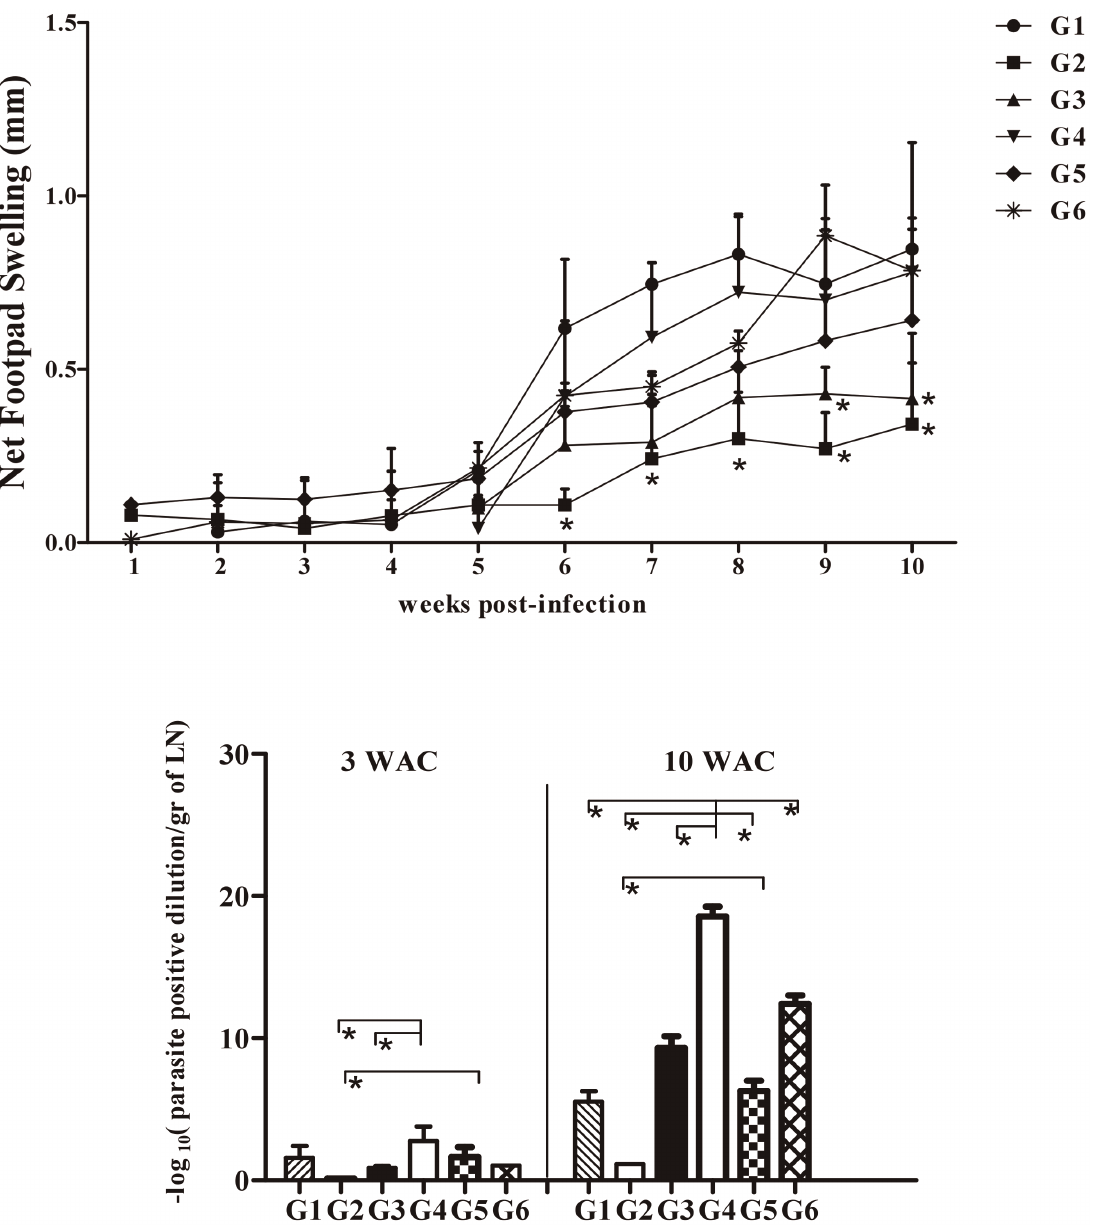
Figure 6. The course of infection with L.major GFP + in C57BL/6 mice vaccinated with different modalities. C57BL/6 mice were immunized in the right footpad with L. tarentolae CPA/CPB/EGFP (G1; rLive/rLive); primed with DNA PpSP15 and boosted with L. tarentolae CPA/CPB/ EGFP and DNA PpSP15 (G2; DNA/rLive + DNA); primed and boosted with L. tarentolae CPA/CPB/EGFP and DNA PpSP15 (G3; DNA + rLive/DNA + rLive); injected with PBS as control (G4), vaccination and boosting with VR1020-SP15 (G5, DNA/DNA); G6: vaccination and boosting with L. tarentolae EGFP + (G6, control Live/Live). All animals were challenged with stationary phase L. major (2 6 10 6 /mice) plus SGH (0.5 pair) in the left footpad except for G1 and G6 which only received L. major . A) The footpad swelling represents the Mean 6 SD of 12 mice per group. Asterisks indicate statistical significance (Mann Whitney U test, p , 0.05) compared to the control group (G4). B) Parasite burden per lymph node in all groups at 3 and 10 weeks post challenge (WAC). Each data point represents the Mean 6 SD of 4 lymph nodes per group. Statistics were carried out by ANOVA ( p , 0.05 denoted as *). Values of two independent experiments are shown in the figure.